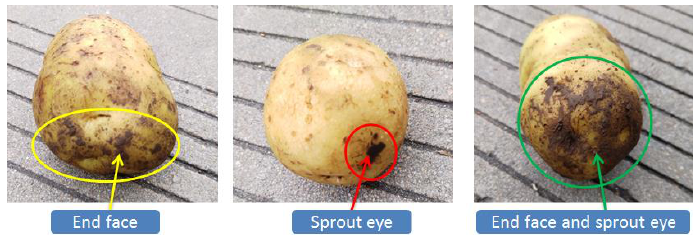
Figure 12. Characteristics of impurity in potato tubers after pre-cleaning and rough cleaning.